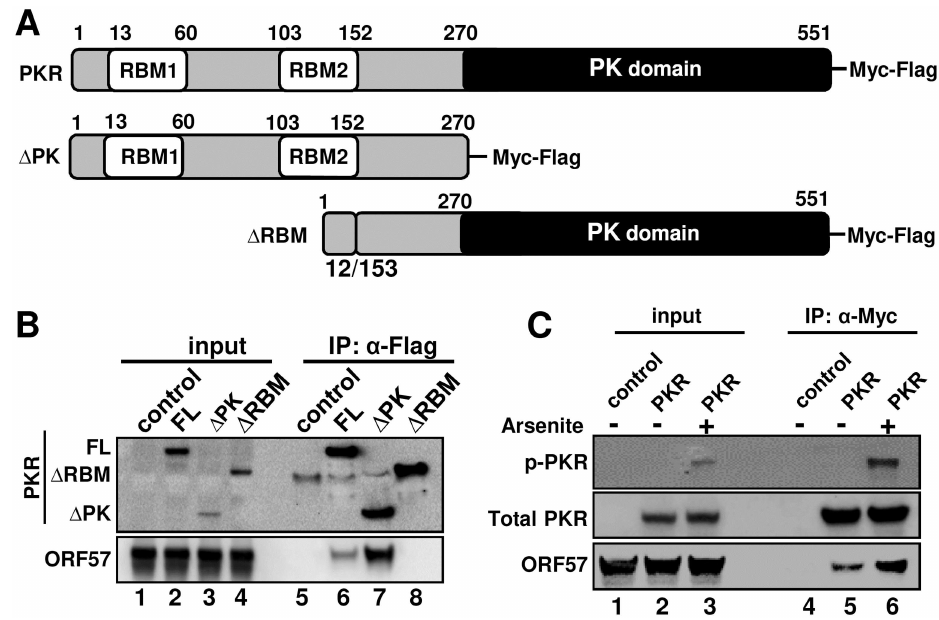
Fig 7. Viral ORF57 interacts with the RBM domain of PKR. (A) Schematic diagrams (not in scale) of PKR and its deletionmutants. RBM, dsRNA-bindingmotifs; PK domain,protein kinase domain.Numbers above each diagram represent amino acid positionsin PKR protein (B) Mappingof ORF57-PKR interactingdomains. HEK293cell extract containing Myc-Flag-tagged full-lengthPKR or its deletionmutant Δ PK or Δ RBM was mixed with the cell extract containing untaggedORF57. The mixture was then digestedwith RNase A/T1 and immunoprecipitatedwith an anti-Flag antibody for PKR. The proteinsin the pulldownwere detected by Western blot using anti-ORF57 or anti-Flag for PKR. (C) ORF57 interacts more efficiently with phosphorylated PKR. HEK293 cells expressingfull-lengthPKR-Myc-Flag were treated with arsenite for 30 min. Total cell extract was mixed with another HEK293 cell extract containing ORF57-Flag and digestedwith RNase A/T1. The PKR-ORF57 complex was pulleddown with anti-Myc beadsand blotted by anti-Flag antibodyfor total PKR, anti-phosphorylated PKR (Thr 451) for p-PKR and anti-ORF57 for ORF57.